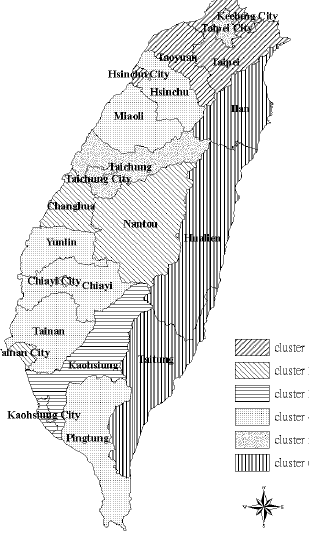
Figure 3: Map of the CA based on regional air pollution